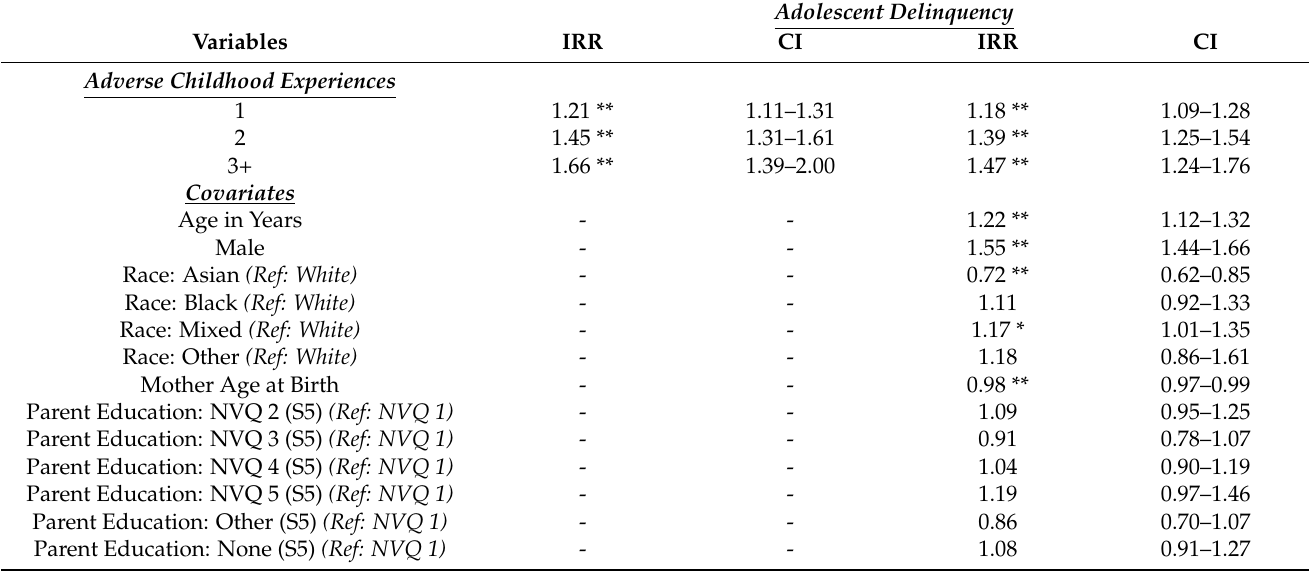
Table 2. Unadjusted and Adjusted Negative Binomial Regression Models of the Association between Adverse Childhood Experiences and Adolescent Delinquency ( N =